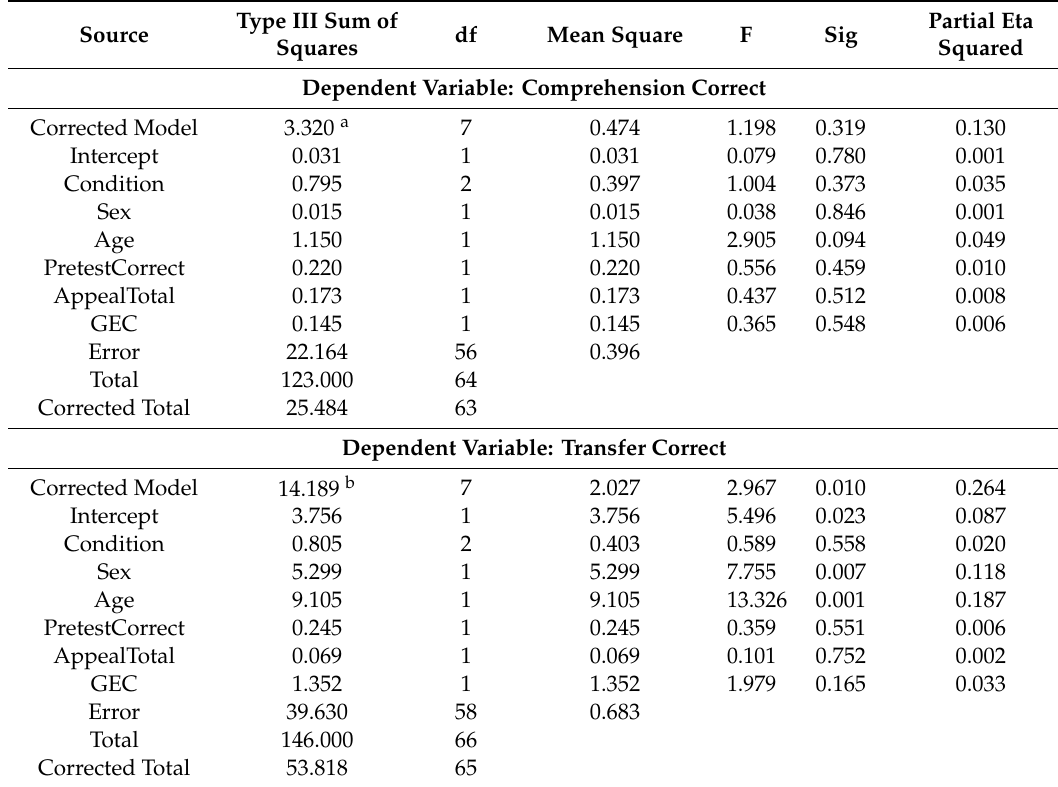
Table A1. Tests of Between-Subjects E ff